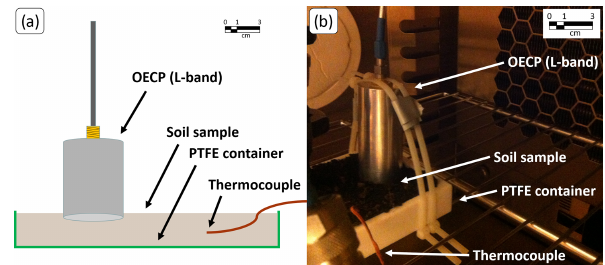
Figure 4. (a) Side view and (b) photo of the cold chamber experi- mental setup at the Laboratoire de l’Intégration du Matériau au Sys- tème (Bordeaux, France) for the slow freeze–thaw